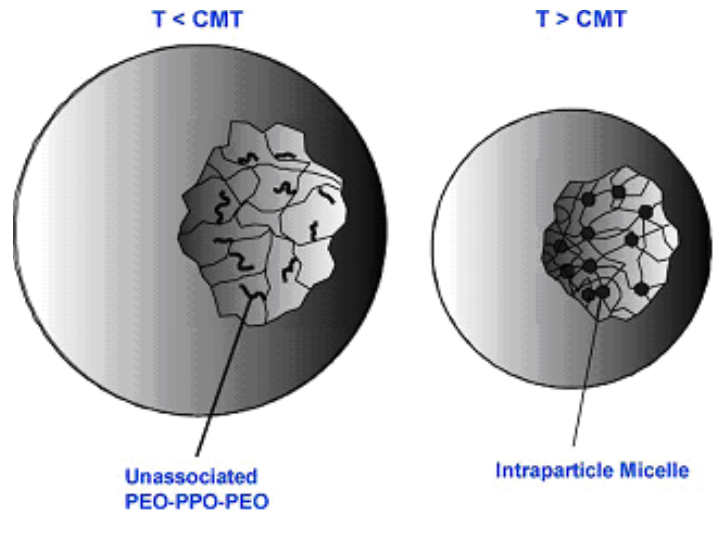
Figure 8. Structure of the cross-linked Pluronic-PAA microgel particles